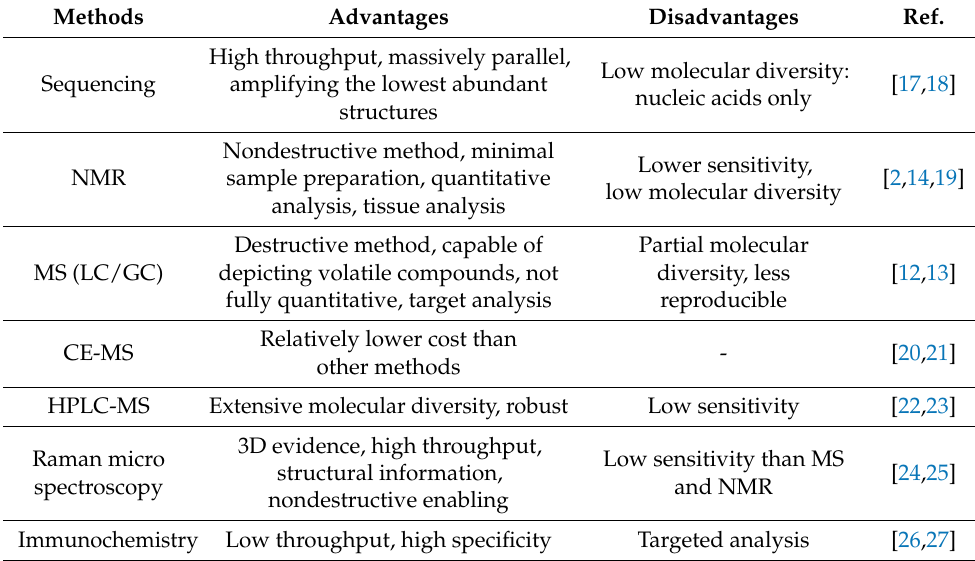
Table 1. Recent analytical research technologies applied to metabolite profiling. The major omics techniques, functionalities benefits, and ability to support to metabolomics/metagenomics analysis.